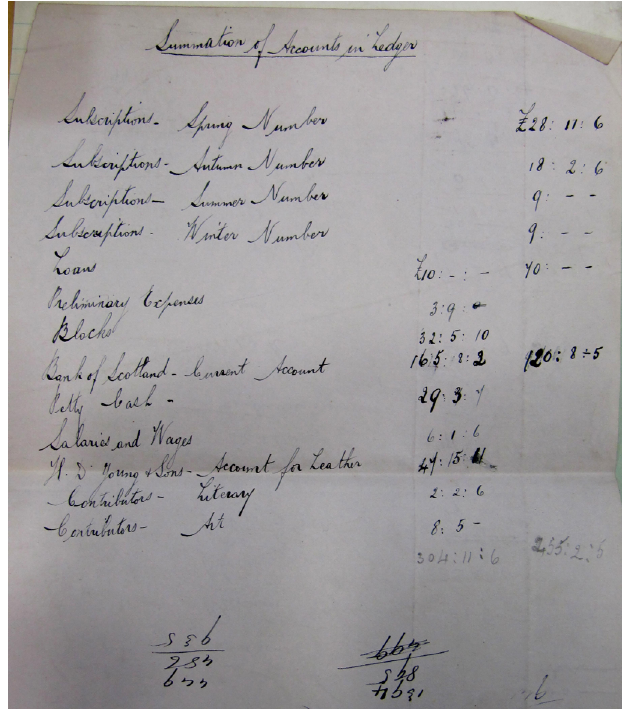
Fig. 8 ‘Summation of Accounts in Ledger’, SUA, T-GED 8/1/2, Glasgow, Strathclyde